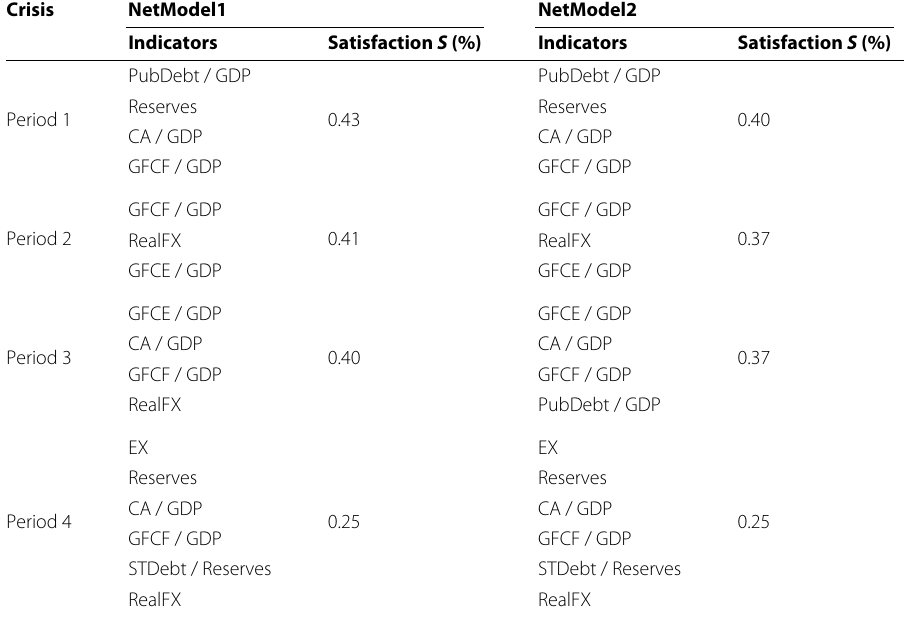
Table 4 Most Promising Indicator Combinations Targeted Community-Structure : NetModel1 & NetModel2 Crisis